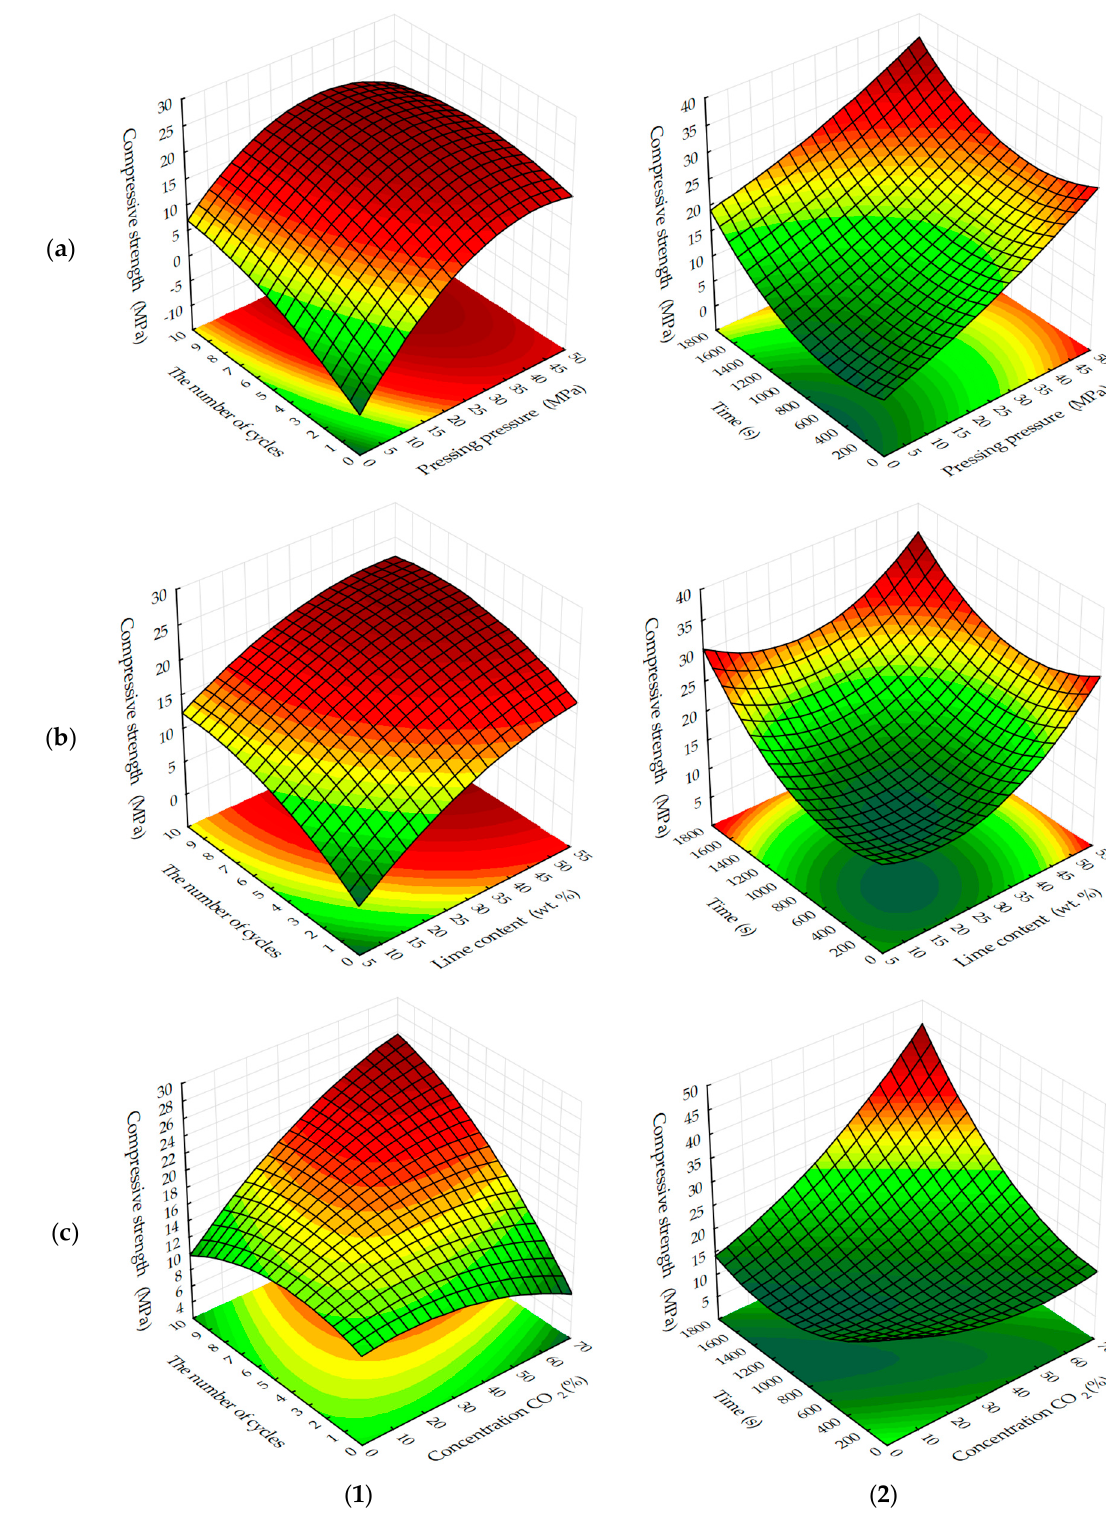
Figure 4. Compressive strength response surfaces of testing samples carbonated by dynamic ( 1 ) and static ( 2 ) methods depending on a number of cycles/time of carbonation and: ( a ) pressing pressure; ( b ) lime dust content; ( c ) CO 2 concentration (at zero level of variation of other factors).